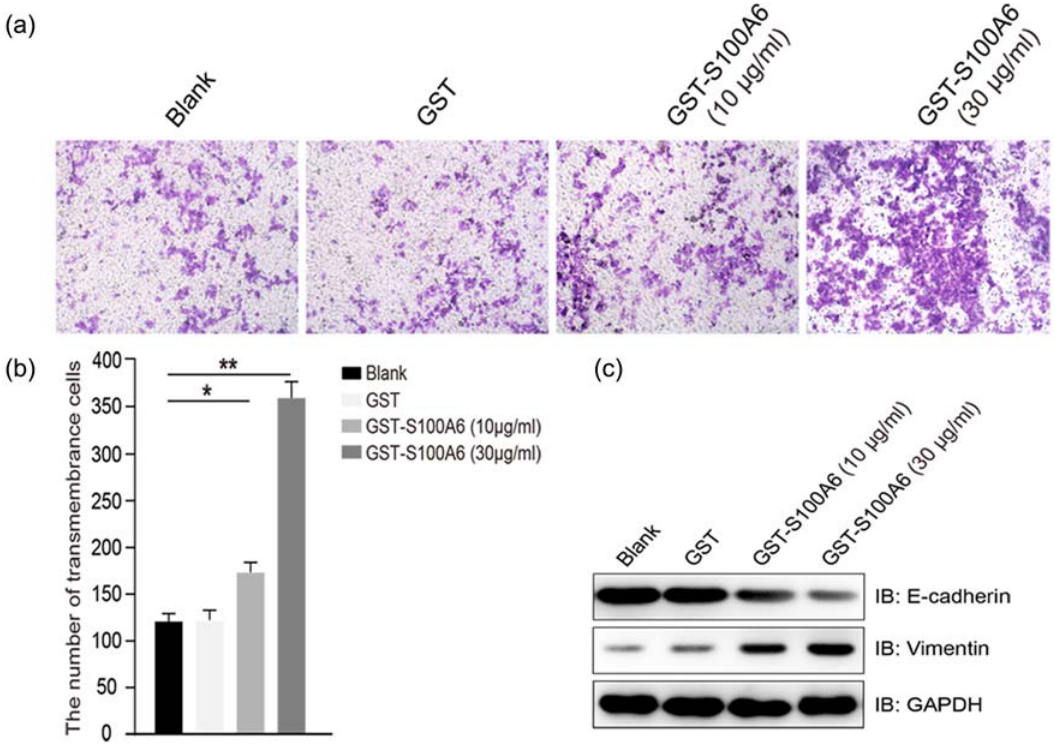
Figure 4: Exogenous S100A6 promotes the migration of HepG2 cells. ( a and b ) Detection of the migration of HepG2 cells by transwell assay; * P < 0.05 and ** P < 0.01. ( c ) Immunoblotting shows the E - cadherin and vimentin protein levels in HepG2 cells treated with GST or GST -